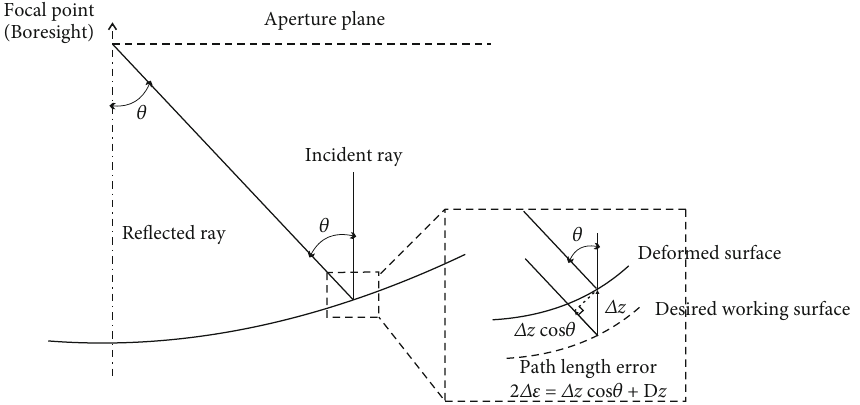
Figure 3: Geometric relation between path length error and antenna surface deformation from Ref.